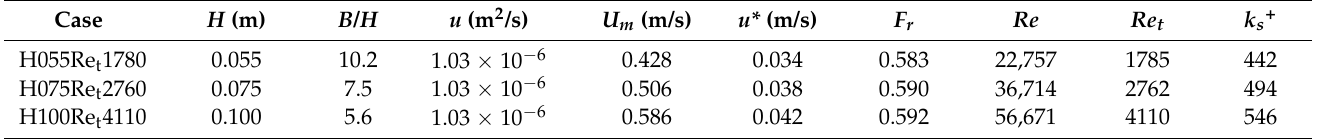
Table 1. Flow conditions for each flow case (a) .